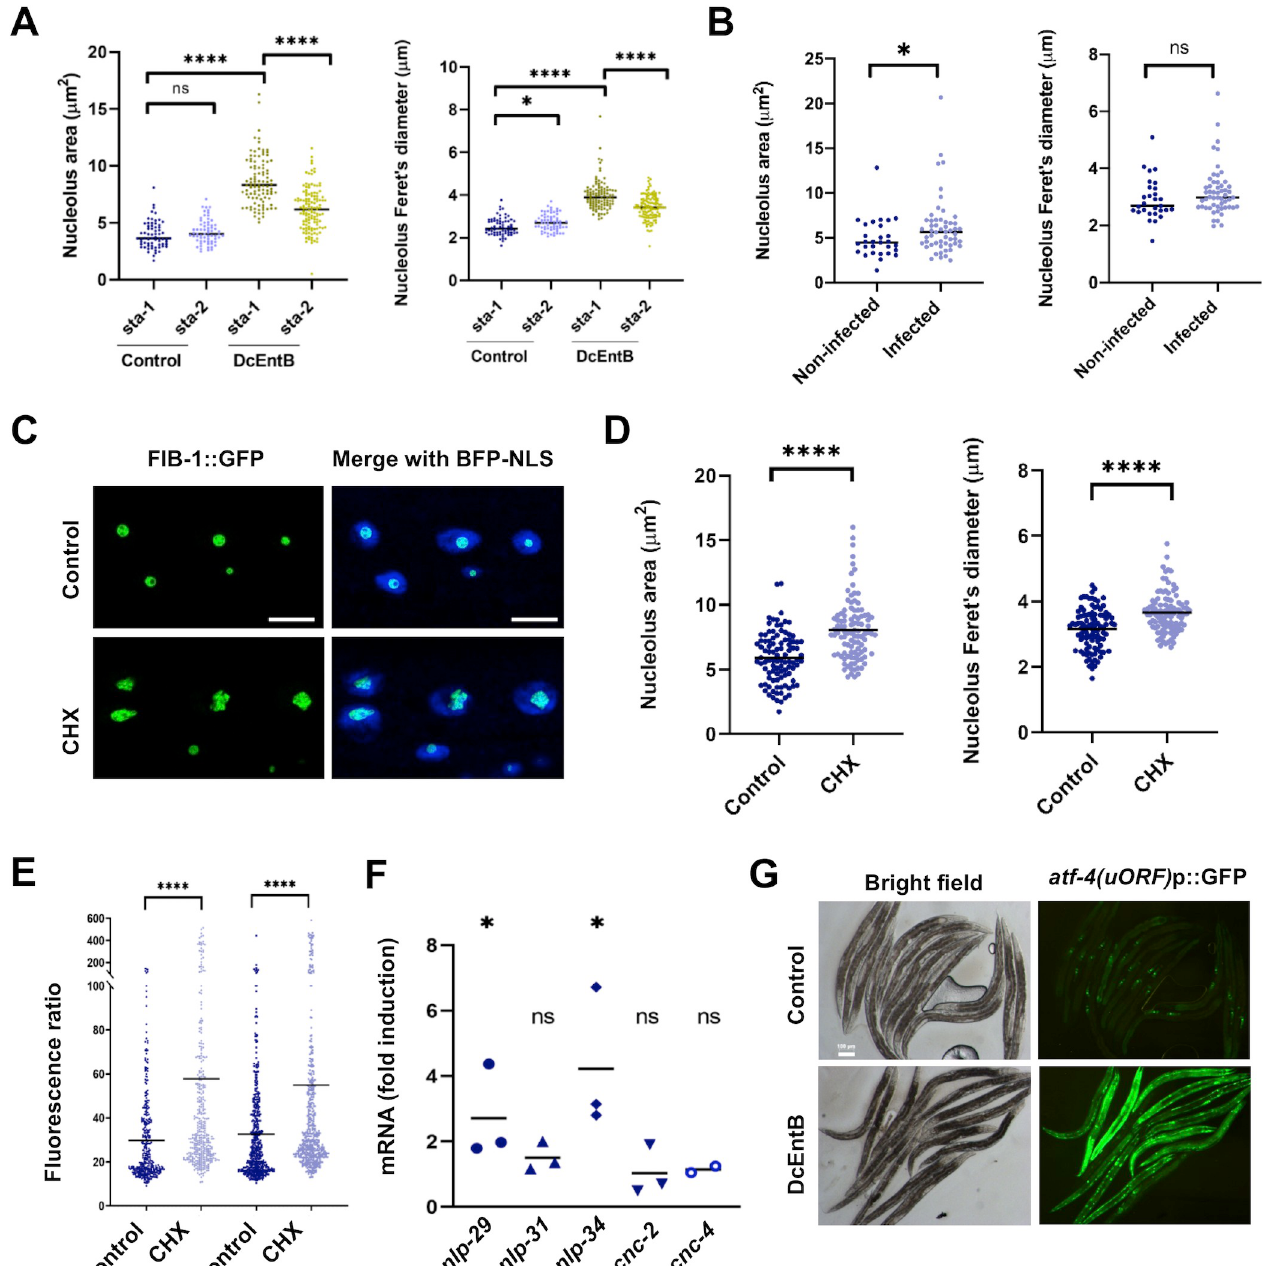
Fig 9. Relationship between nucleolar morphology, translation and AMP gene expression. ( A , B ) Quantification of nucleolus area and Feret’s diameter in young adult worms expressing FIB-1::GFP together with (DcEntB; IG1984) or without (Control; IG1596) DcEntB following RNAi against sta-1 or sta-2 ( A ) or in IG1596 worms following 24 h infection ( B ). ( C ) Representative confocal images of young adult IG1596 worms (that express BFP-NLS in addition to FIB-1:: GFP) after exposure for 6 h to cycloheximide (CHX; lower panels) compared to control (upper panels); left and right panels: green, and green and blue channels together, respectively), scale bar, 5 μ m. ( D ) Quantification of nucleolus area and Feret’s diameter in young adult worms expressing FIB-1::GFP (IG1596) after exposure for 6h to CHX, compared to control untreated worms. ( E ) Quantification of relative green fluorescence of young adult worms carrying frIs7 ([ nlp-29p :: GFP ; col-12p :: dsRed ]; IG274) after exposure for 6 h to CHX, compared to control untreated worms. The results from 2 independent experiments are shown. ( F ) Quantitative RT-PCR analysis of the expression of nlp and cnc genes in worms carrying frIs7 (IG274) following exposure as young adults to CHX for 6 h. Results from 3 independent experiments are shown as averages with standard deviation, relative to the expression levels in age-matched control worms. Statistical significance was determined using a nonparametric Mann Whitney test; � p < 0.05, ���� p < 0.0001, ns, not significant. ( G ) Representative images (left panels: white light, right panels: green fluorescence) of one day old adult worms carrying an atf-4p(uORF) ::GFP reporter also expressing DcEntB (IG2045; bottom panels), and their siblings without the DcEntB transgene (upper panels). Scale bar, 200 μ m.